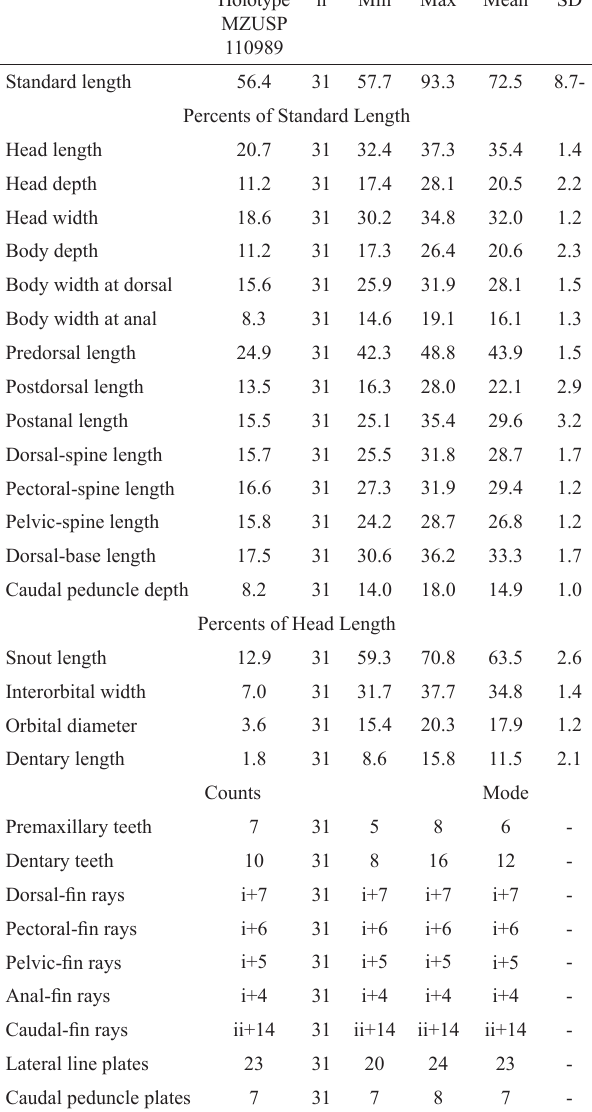
Table 4. Morphometric and meristic data of Spectracanthicus tocantinensis . Values are given as percents of standard length or head length. SD = standard